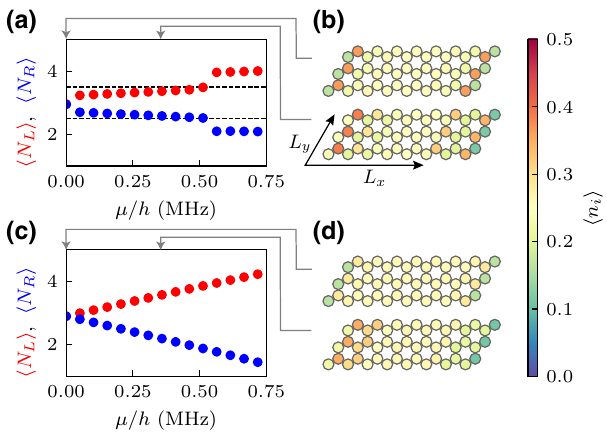
FIG. 5. The detection of fractional charges. We consider a cylinder with L x = 8 and L y = 3 that is finite along the x direc- tion. We apply a chemical potential μ ≥ 0 to the 12 leftmost sites S S L and the opposite potential to the 12 rightmost sites R . Using DMRG with bond dimension χ = 200, we calculate the number of particles on the left (cid:7) N L (cid:2) and on the right (cid:7) N R (cid:2) as a function (cid:9) of μ with N L , R = n i . (a) The number of particles (cid:7) N L , R (cid:2) i ∈ S L , R jumps in steps of 1 / 2, indicated by the dashed lines. (b) The par- ticle density (cid:7) n i (cid:2) increases on the leftmost sites and drops on the rightmost ones if μ is increased. (c) For comparison, we study our system in the topologically trivial sector, where the number of particles (cid:7) N L , R (cid:2) changes continuously. The system is brought into the trivial sector by increasing (cid:3)/ h by 50 MHz, so that the |+(cid:2) state can be neglected. (d) The corresponding changes in the particle density (cid:7) n i (cid:2)